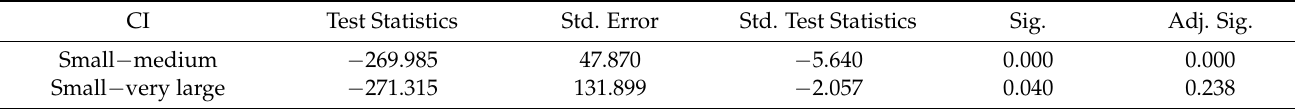
Table A1. The output of the pairwise firm size